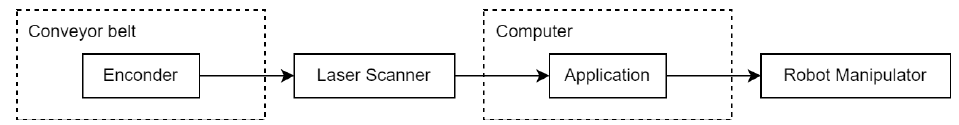
Figure 4. Experimental setup block